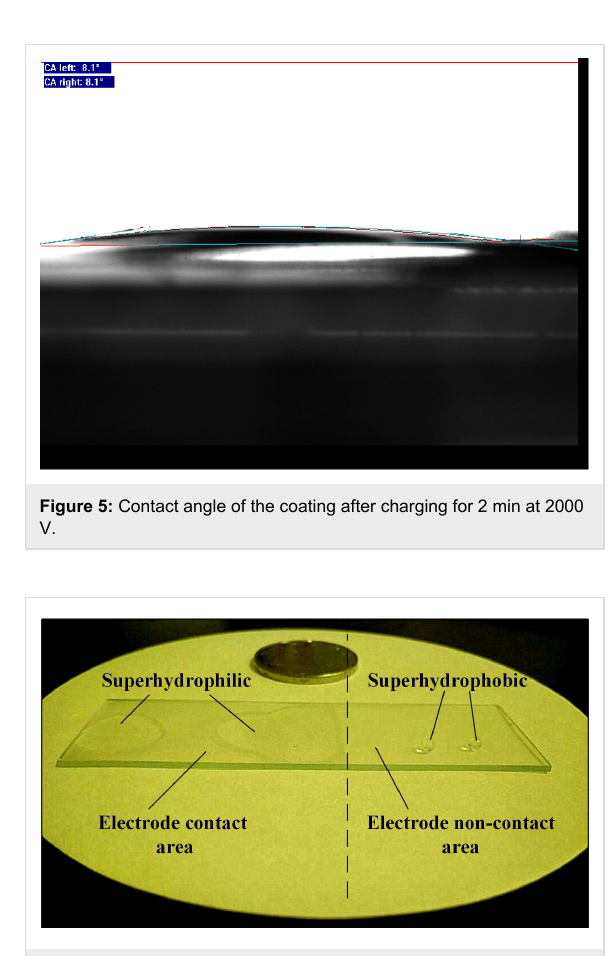
Figure 6: Contrast in wettability of the electrode contact area (after charging for 2 min at 2000 V) and the non-contacted area for the same coating/sample.